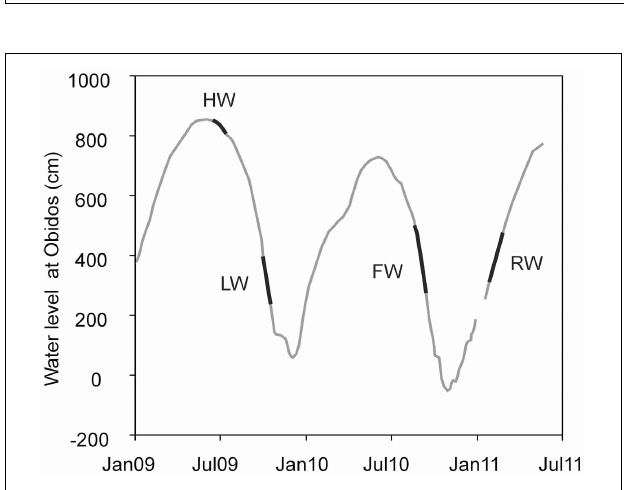
FIGURE 3 | Seasonal water level changes of the Amazon River main stem at the town Óbidos (station Amazon 4) (RW, rising water; HW, high water; FW, falling water; LW, low